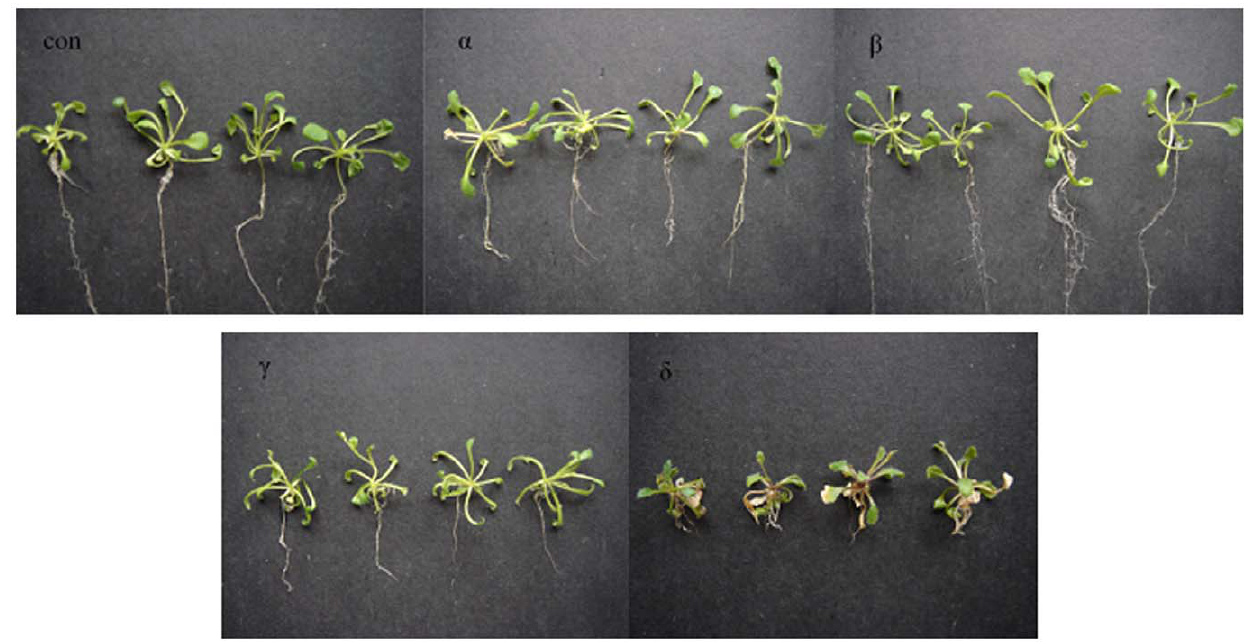
Figure 1. Phenotype of Arabidopsisthaliana exposed to a -, b -, c - and d -HCH (Exposure concentration: 5 mg/L) for four weeks.